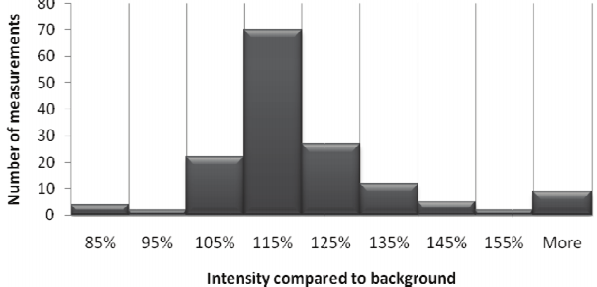
Fig. 11. Histogram of the relative intensity of the observed light in the ship plume compared to the background at the wavelength 311nm. This is relevant for the optical SO 2